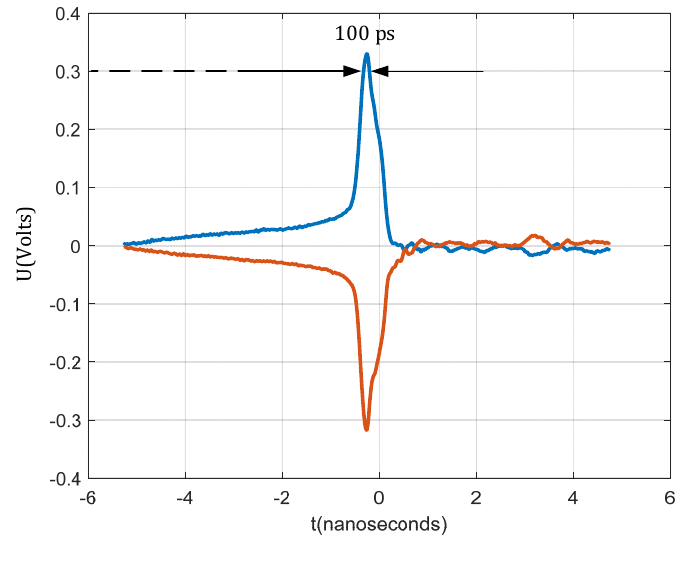
Figure 6. Measured strobe 100 ps pulse duration at diode forward voltage, when the diode opens the bridge, and sample input RF signal. Measurements were taken on the balun’s